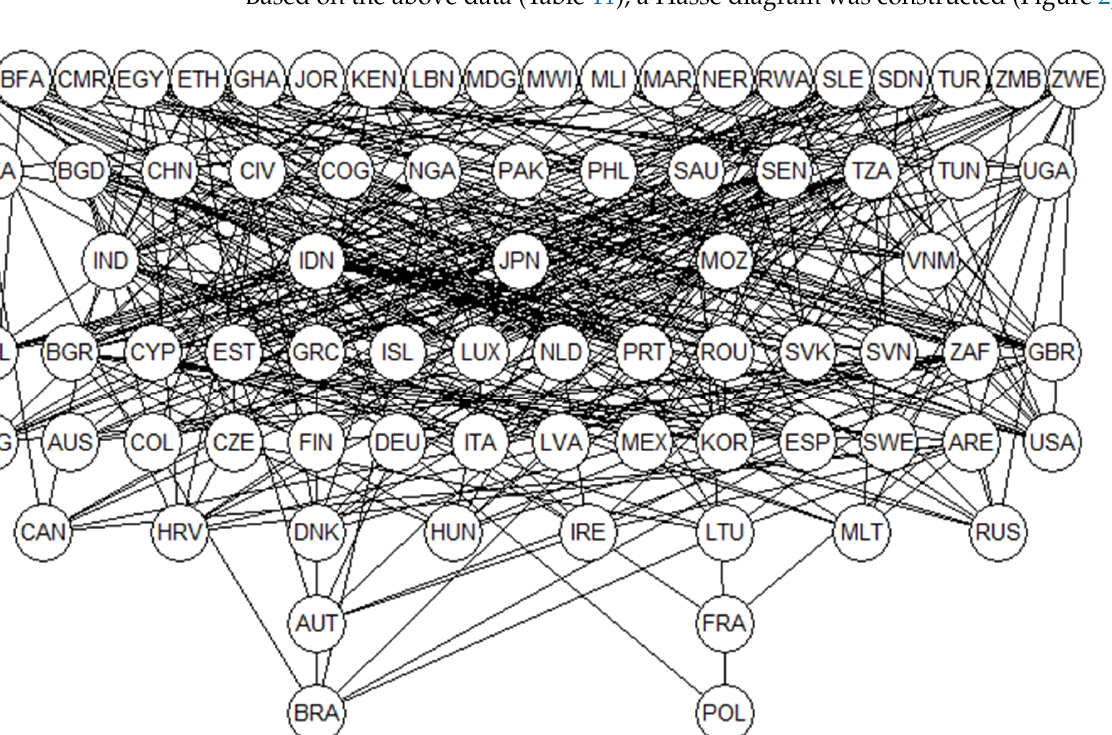
Table 12. Four weighting schemes, as defined within the food sustainability study [31].